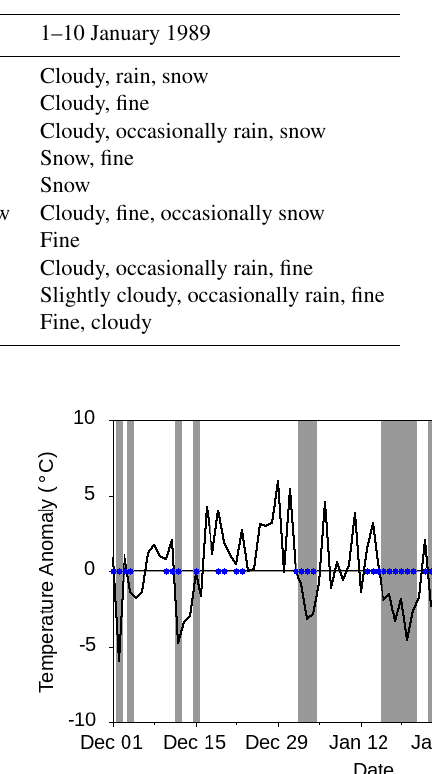
Table 1. Comparison of weather descriptions from the Japan Meteorological Agency (JMA) Aomori observatory for 1–10 January 1980 and 1989.